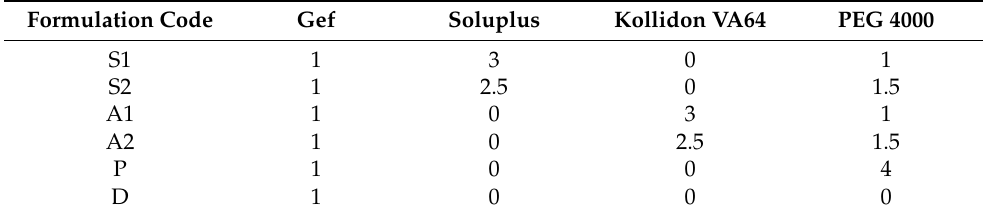
Table 1. Gefitinib (Gef)-carrier ratio used to prepare solid dispersion (SD) ( w / w ). Formulation